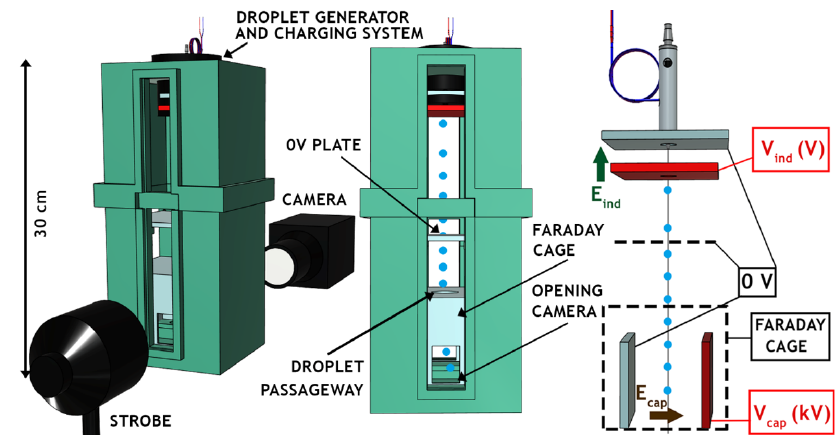
Figure B1. Setup to obtain the droplet charging relationship – (left and centre) 3D view and (right) schema (not to